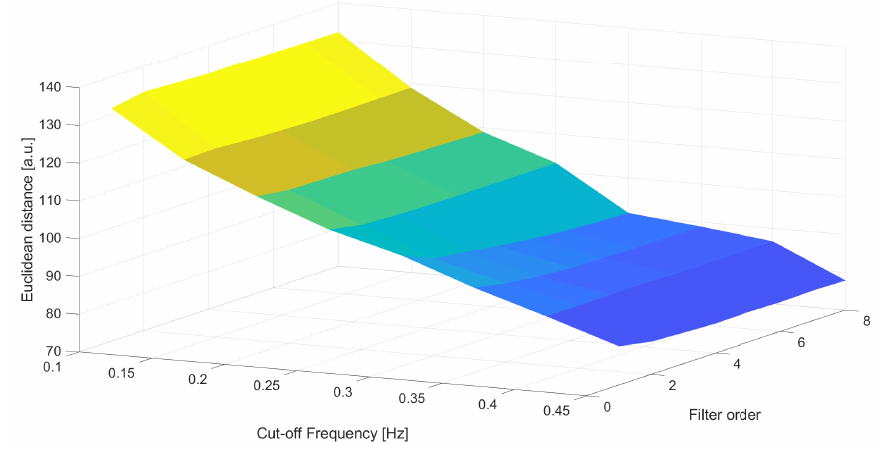
Figure 12. C1—Distance analysis results for HIMU. Events are reported as pulsed train (green solid line).